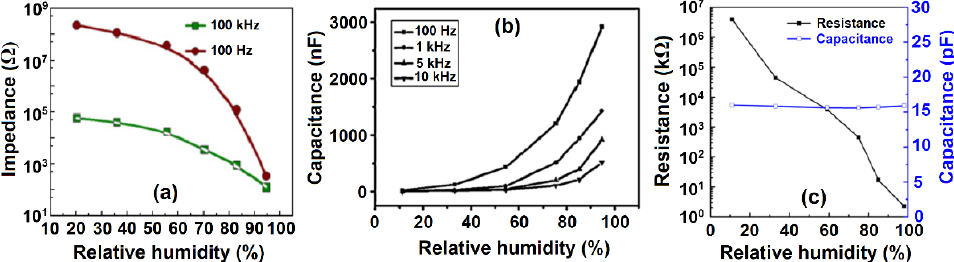
Figure 3. Panel ( a ): impedance (real) vs. RH dependence for a ZnO-based resistive humidity sensor. Reprinted with permission from [79]. Copyright 2013, Elsevier. Panel ( b ): capacitance vs. RH curve for ZnO-based capacitive humidity sensor. Reprinted with permission from [80]. Copyright 2013, Elsevier. Panel ( c ): comparative resistance and capacitance vs. RH curves for a mesoporous resistive LaFeO 3 sensor. Reprinted with permission from [81]. Copyright 2013,